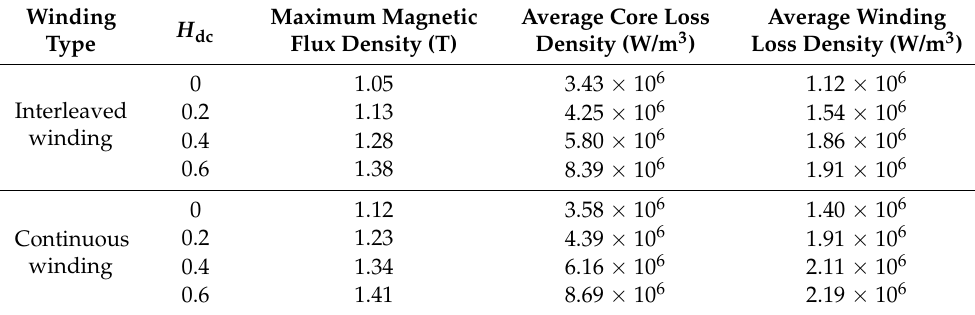
Table 3. Electromagnetic parameters with different DC bias.